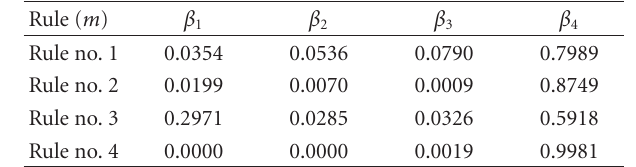
Table 8: Fuzzy densities using GMM.